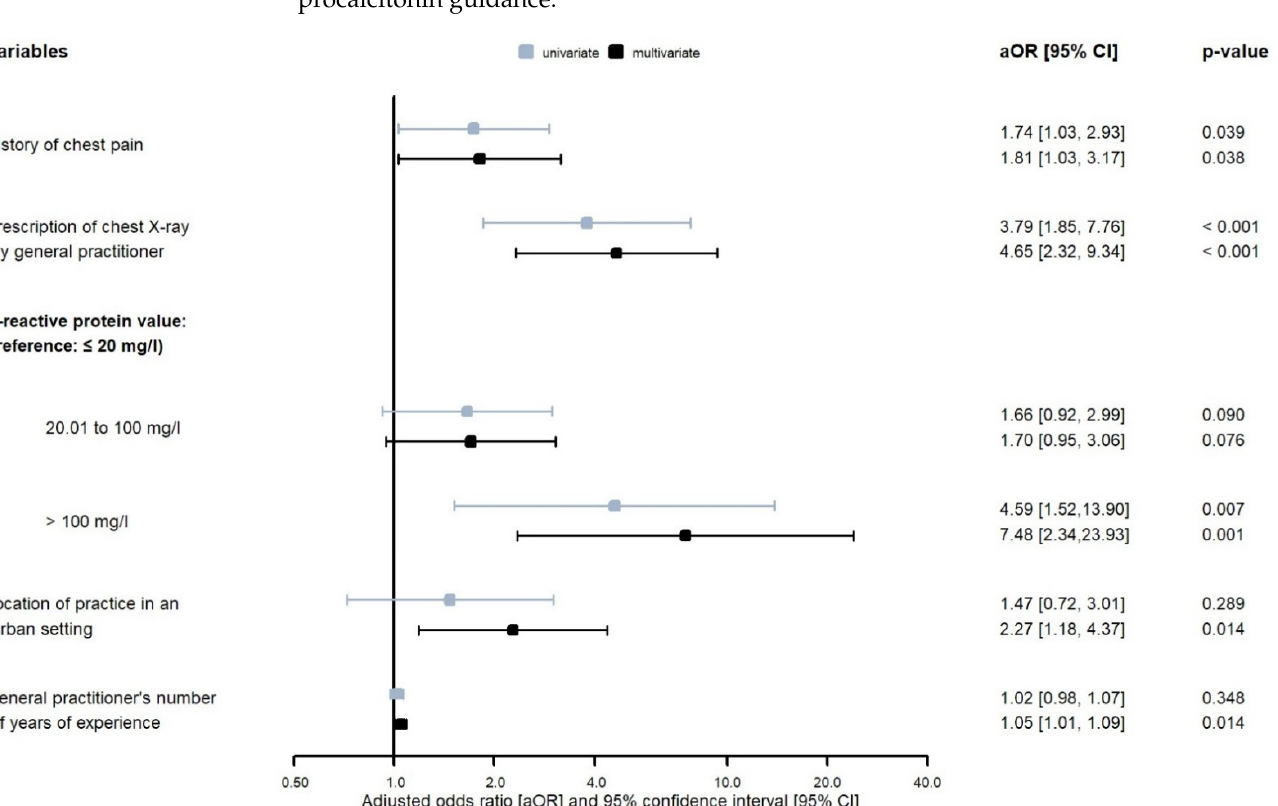
Figure 2. Forest plot showing factors associated with an overruling of initial procalcitonin guidance: univariate and multivariate logistic regression models corrected for clustering within practices.